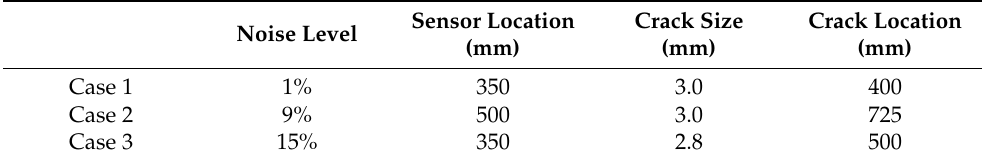
Table 1. Damage cases of a simply supported beam.